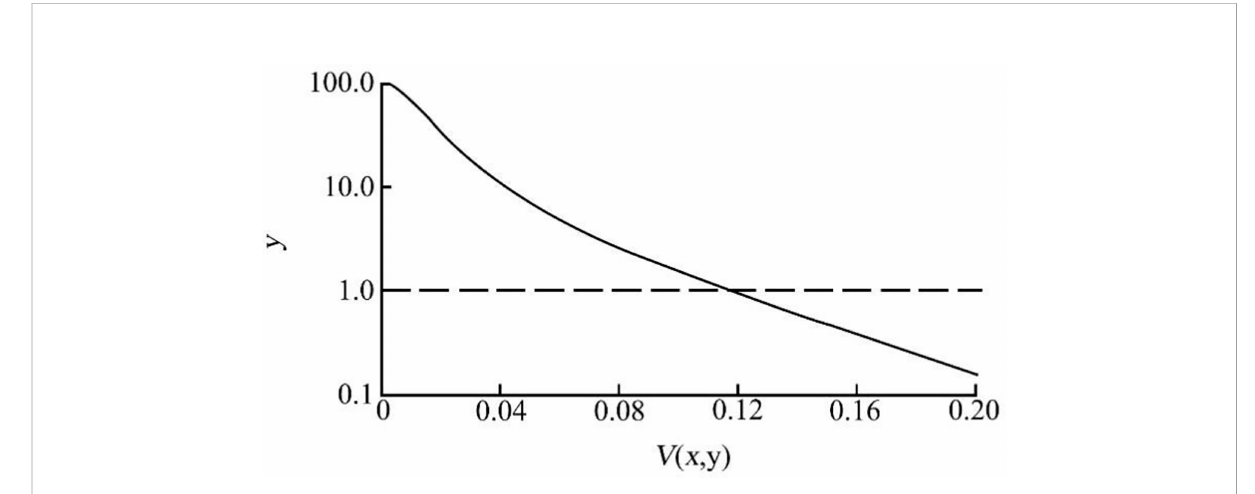
FIGURE 4 Preprocessing function output. Note: — y